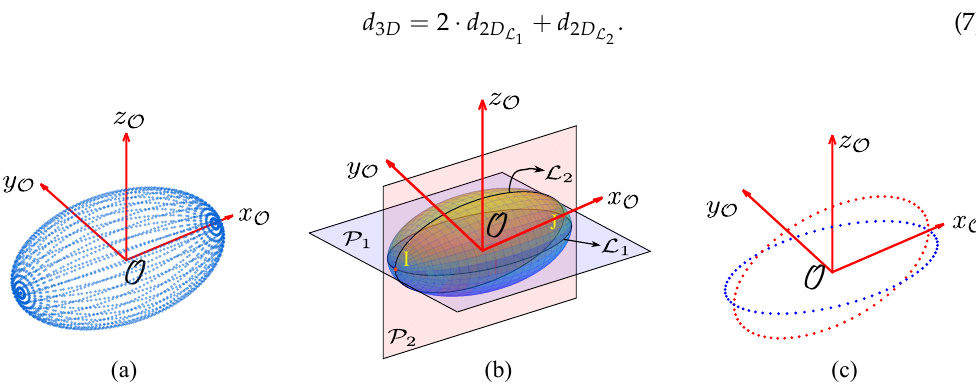
Figure 1. Illustration of complexity reduction; ( a ) contact points when P numbers of planes are considered, ( b ) introducing two orthogonal planes P 1 and P 2 resulting projection lines L 1 and L 2 over object, ( c ) contact points after introducing two orthogonal planes.